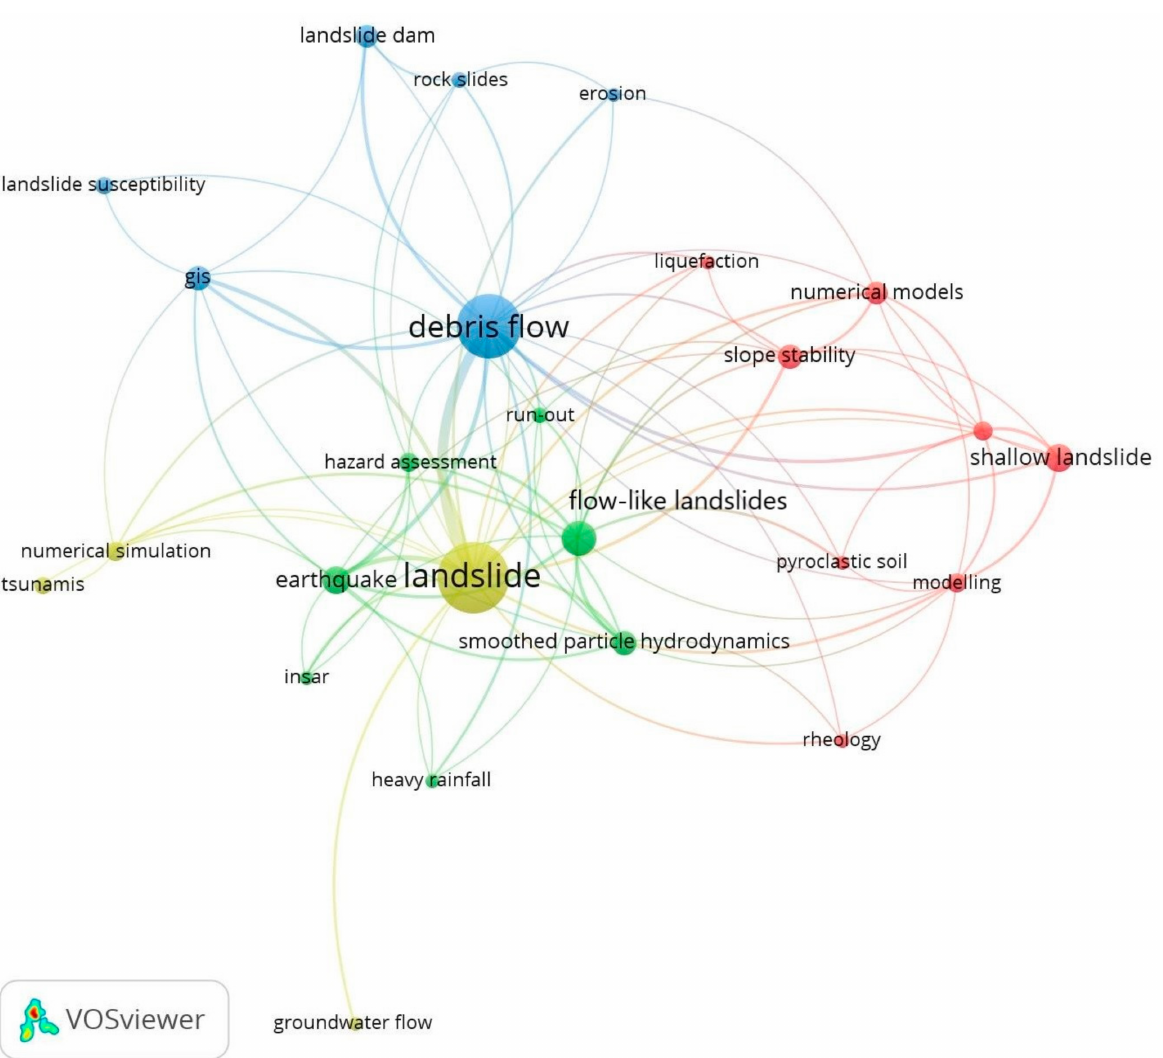
Figure 6. Visualization of the co-occurrence network by assigning a representative color for each cluster. Red color (shallow landslide), green color (flow like landslide), blue color (debris flow) and yellow color